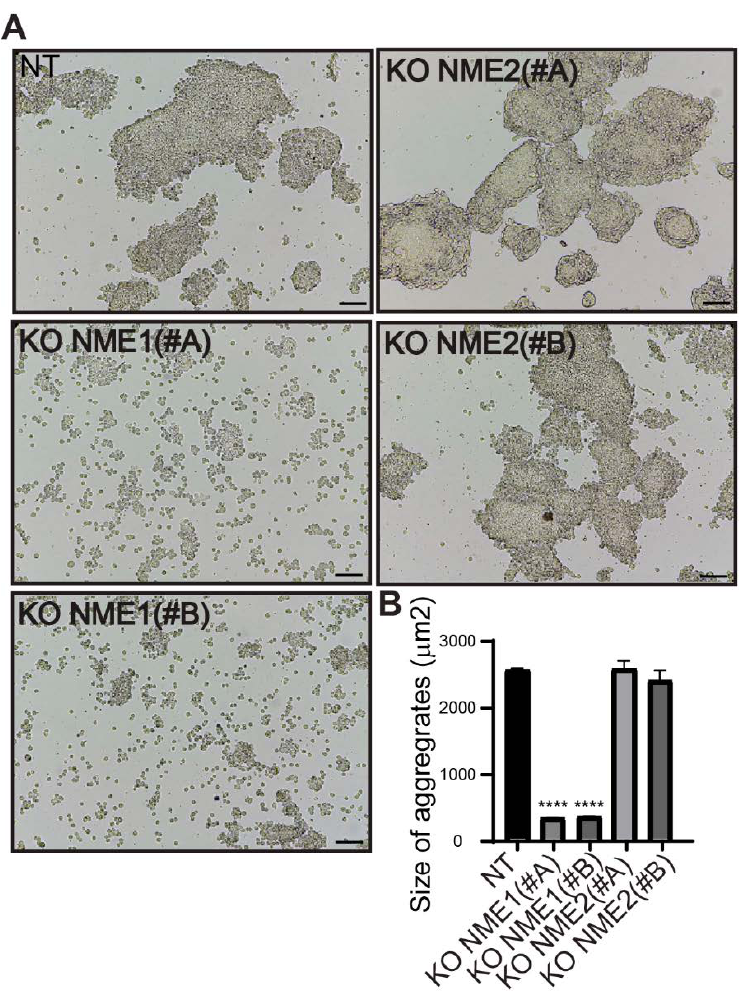
Figure 5. Inactivation of NME1 decreases cell–cell adhesion. ( A ) Representative light microscopy images showing dispase aggregation assays of MCF10DCIS.com cells in which NME1 or NME2 was inactivated. Scale bar, 100 µm. ( B ) The size of the aggregates was quantified as the area of their horizontal projections. Values shown are the means of three independent biological replicates ± SEM. **** p < 0.0001.